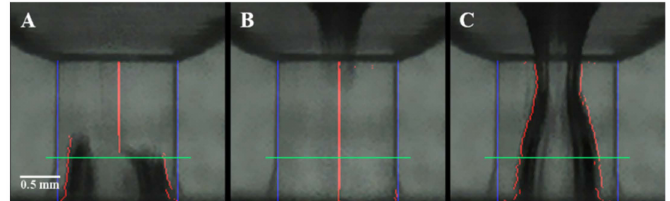
Figure 6. Breakup of the gas core inside the exit orifice of the atomizer ( µ = 0.39 Pa · s; Q L = 40 L · h − 1 , p gas = 0.4 MPa, ALR = 0.05). ( A ) Begin of the breakup. Liquid film was still detectable at the line probe (green line; time: 6.40 × 10 − 3 s). ( B ) Complete breakup. The exit orifice was almost completely filled with liquid (time: 6.45 × 10 − 3 s). ( C ) Fully established gas core after breakup (time: 6.50 × 10 − 3